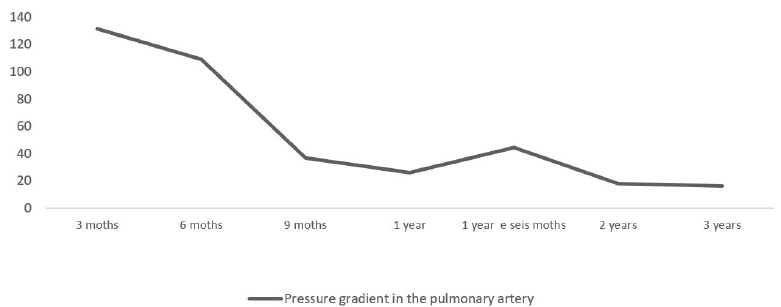
Figure 8. Graphic representing of the variation of the pressure gradient in the pulmonary artery, in relation to the age of the patient after balloon